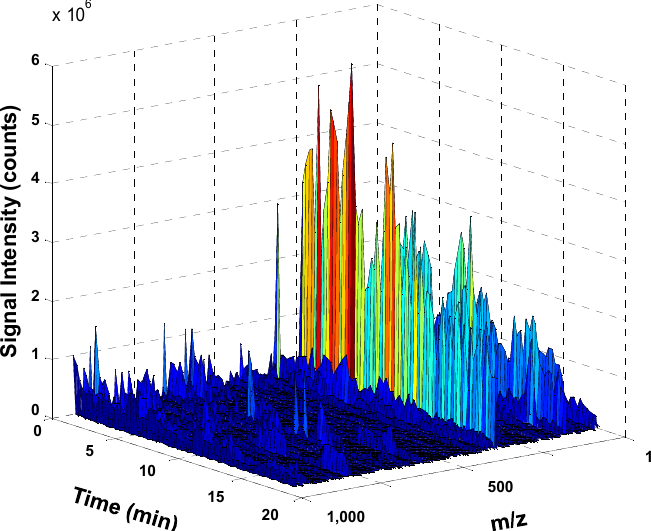
Figure 1. 3D ultra-high performance liquid chromatography-high resolution mass spectrometry (UHPLC-HRMS) fingerprint of a curry sample. For simplification, only the time range from 0–20 min and m / z range from 100 to 1000 is depicted.